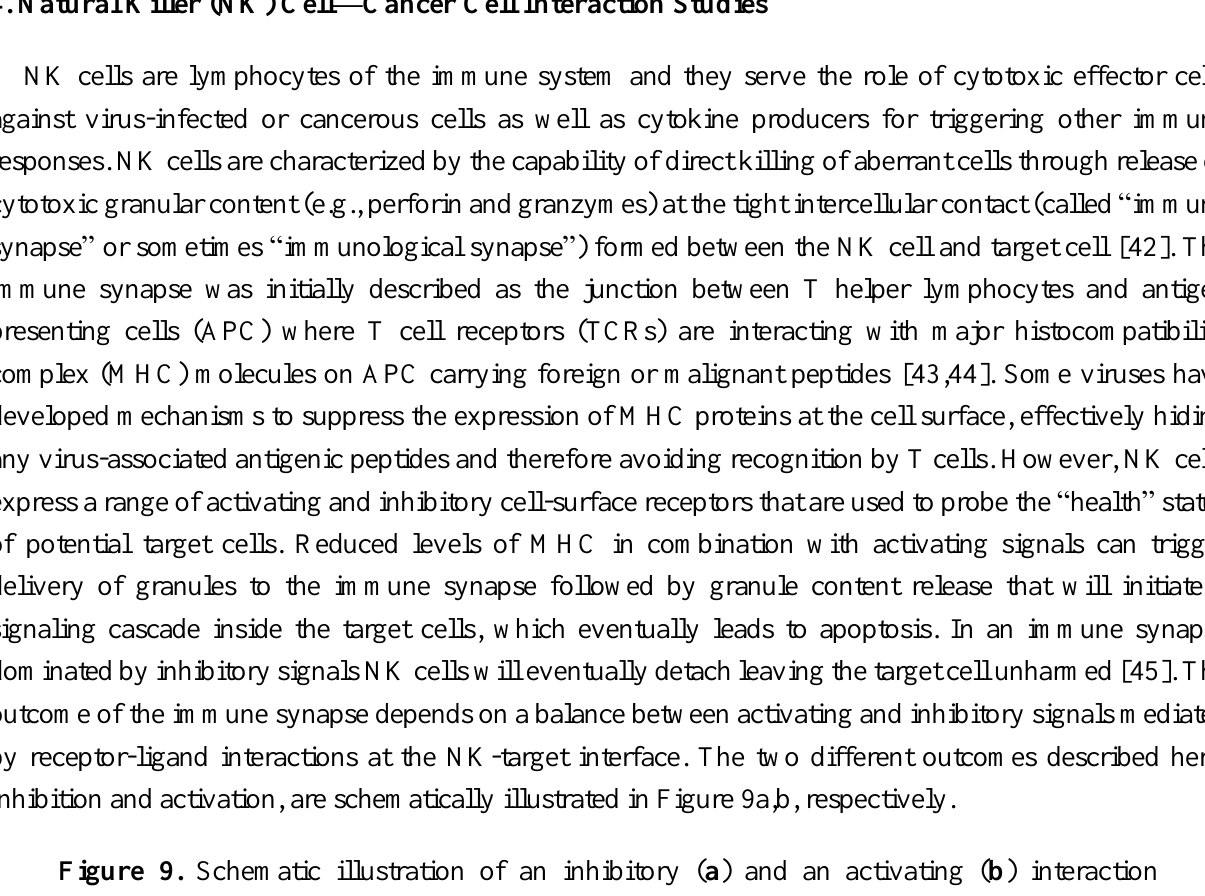
between a natural killer (NK) cell and a target cell. The three different steps (marked with arrows) are (I): Initiation of cell-cell contact, (II): Development of an inhibitory (green) or activating (red) immune synapse, and (III): Detachment ( a ) or killing ( b ) of the target